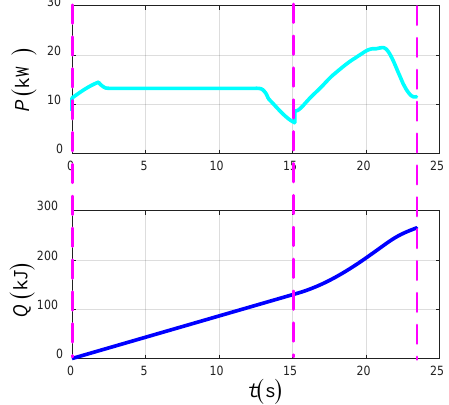
Figure 15. The power and energy consumption in